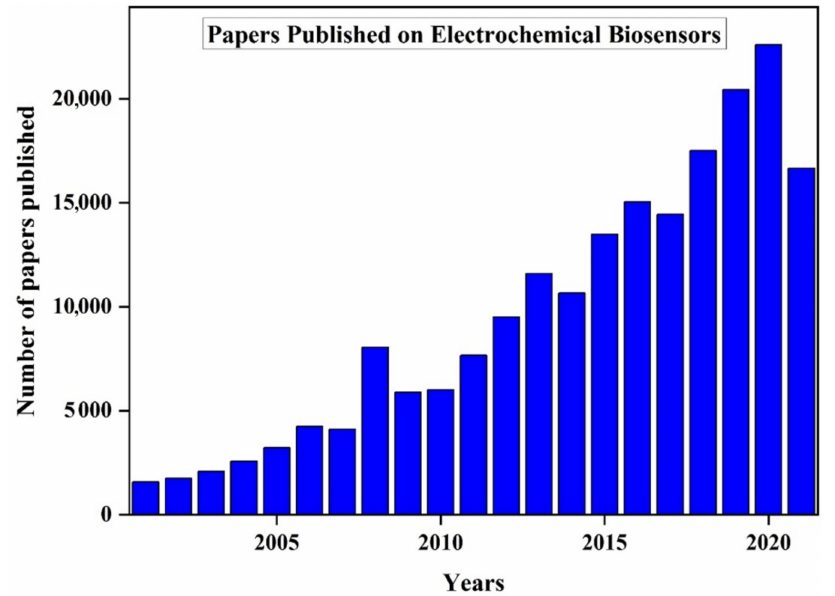
Figure 13. Recent reviews/articles published on electrochemical biosensors from the year 2000 to July 2021. Reproduced from Reference [174]. Copyright 2021, https://www.dimensions.ai/; accessed on 12 August